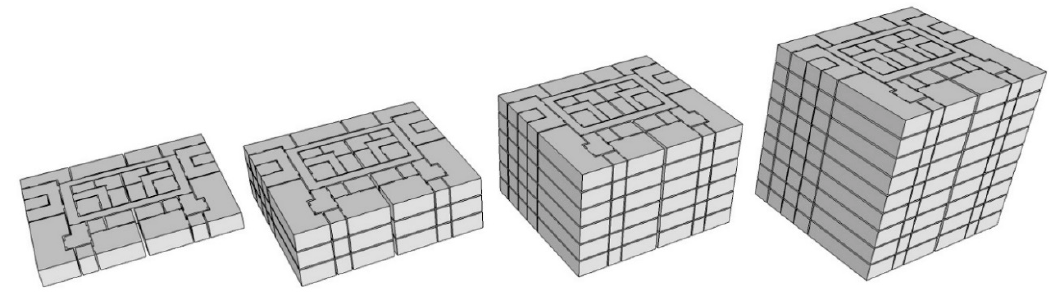
Figure 7. The 3D cadastral datasets.